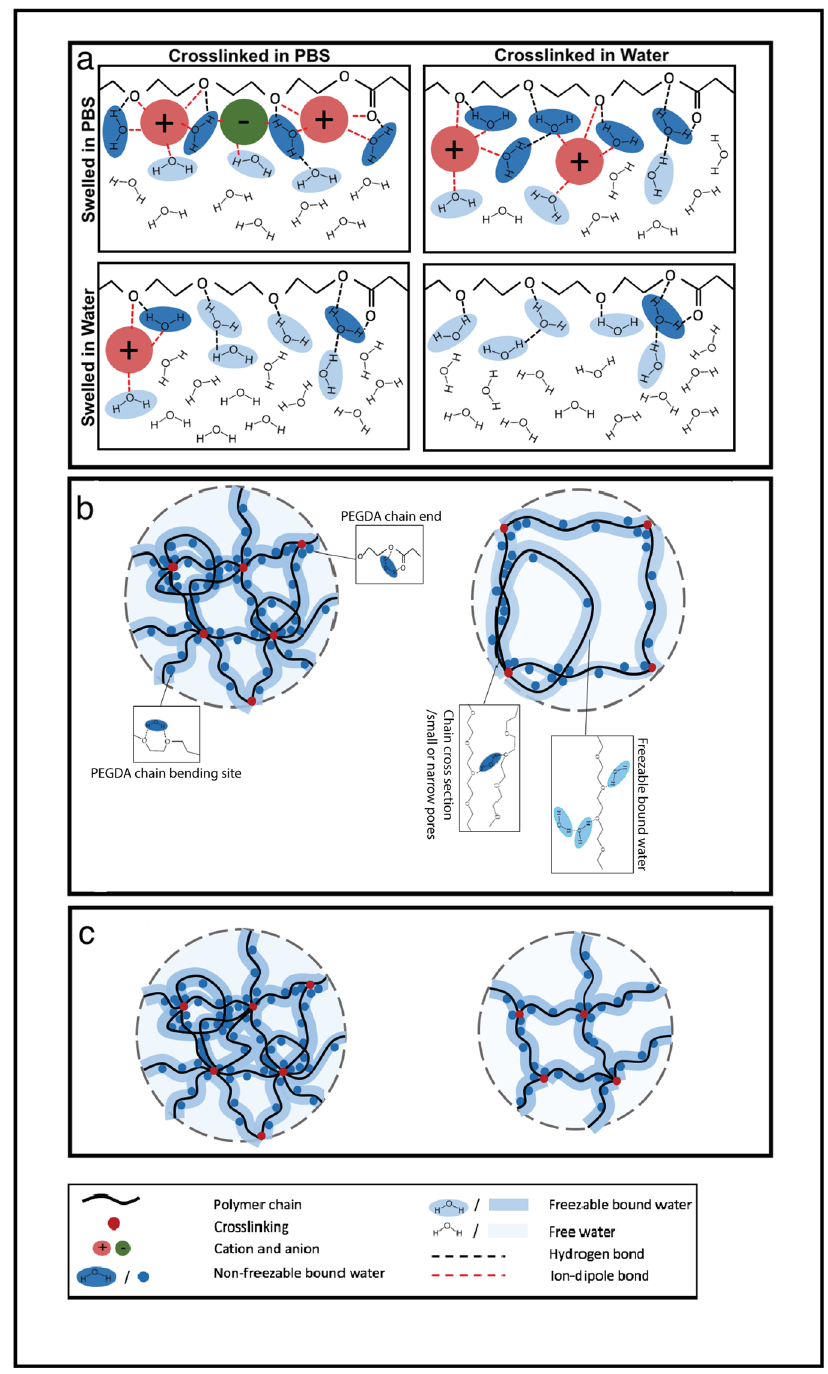
Fig. 1 Graphic illustration of water content in PEGDA hydrogels. a Water content under different swelling conditions. b Comparison of water content in hydrogels with different PEGDA molecular weight. c Comparison of water content in hydrogels with different PEGDA weight fraction. (Figure reproduced from Yang et al, Polymers , 2021, 13 (6), 845,